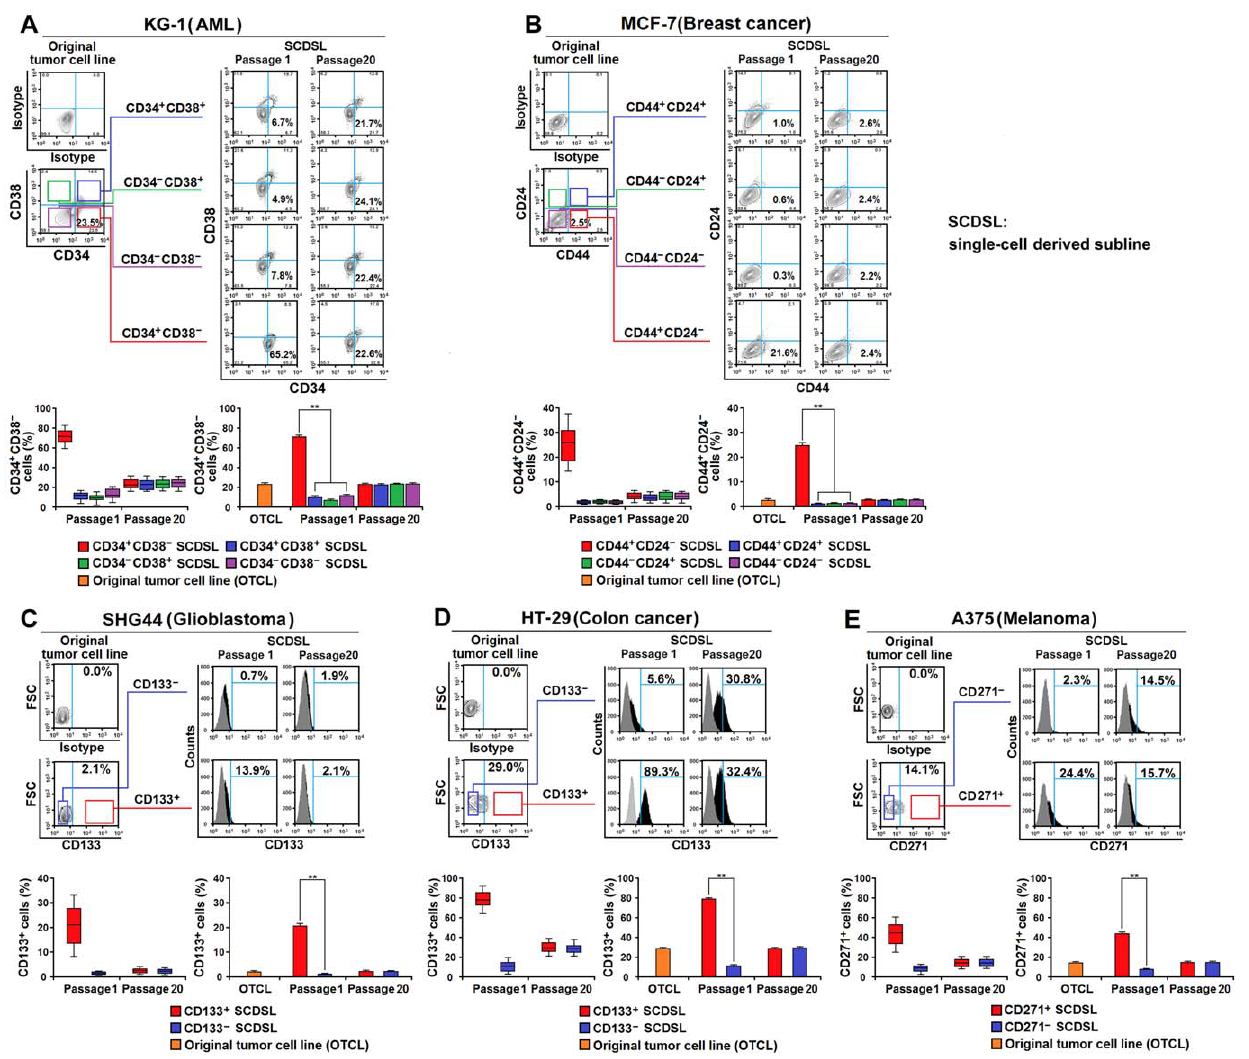
Figure 4. CSC 2 and CSC + tumor cells can generate both progenies. ( A–E ) CSC + and CSC 2 cells from the original tumor cell lines were selected to generate single-cell derived sublines (SCDSLs). The percentage of CSC marker positive cells in the original tumor cell lines or SCDSLs (passage 1 and passage 20) of KG-1 ( A ), MCF-7 ( B ), SHG44 ( C ), HT-29 ( D ), and A375 ( E ) was analyzed by flow cytometry. Box plots show the percentage of CSC marker positive cells in SCDSLs, with the whiskers representing the minimum and maximum values, the central lines representing the median value, and the boxes representing the 25th and 75th percentile. Histograms show the percentage of CSC marker positive cells in original tumor cell lines and SCDSLs. Data of SCDSLs represent mean 6 SEM from 100 samples; Data of original tumor cell lines represent mean 6 SEM from 3 independent experiments; ** P , 0.01 by independent t -test.